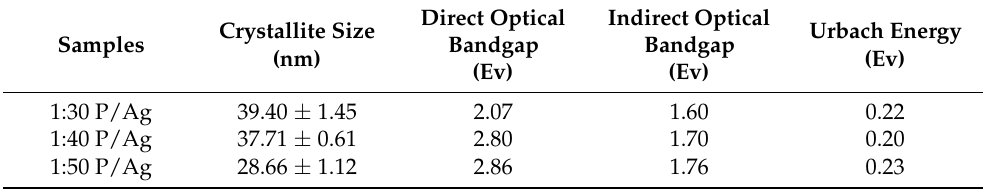
Table 1. The effect of volume ratio on the characteristics of the prepared Ag/Ag 2 O